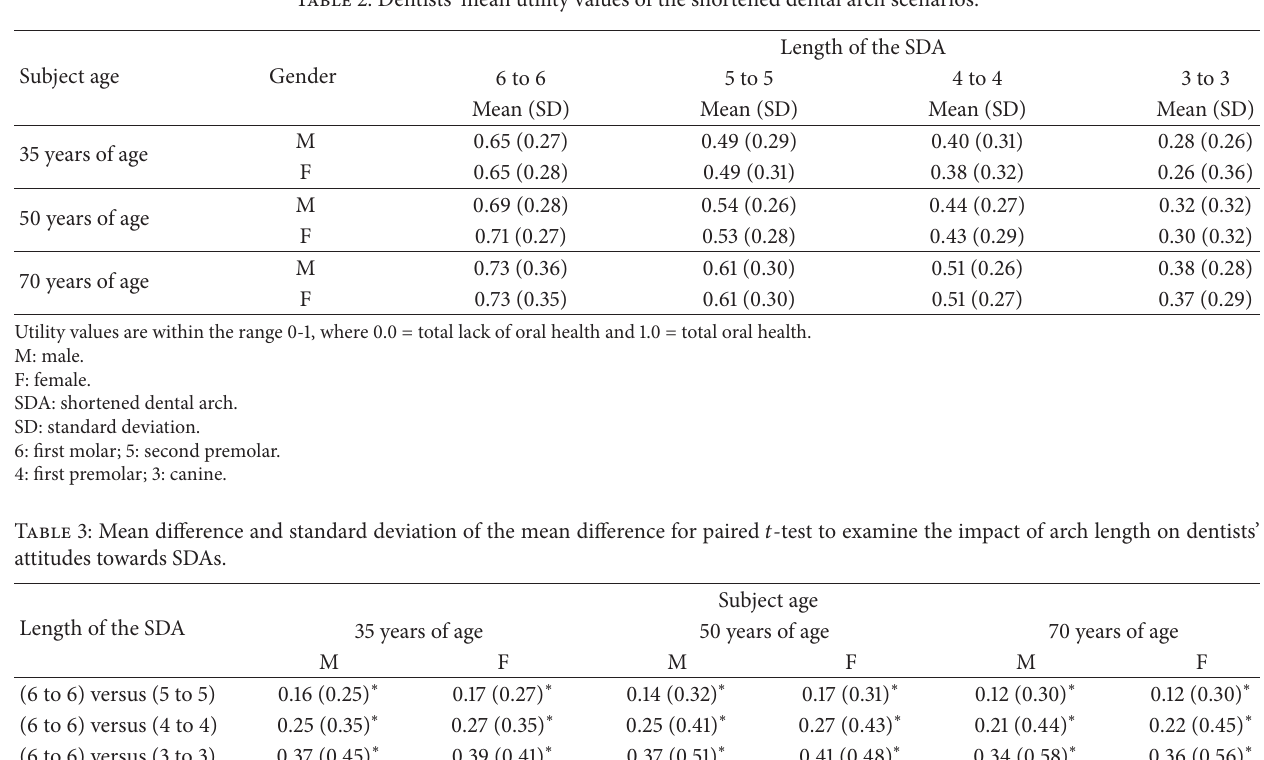
Table 2: Dentists’ mean utility values of the shortened dental arch scenarios.